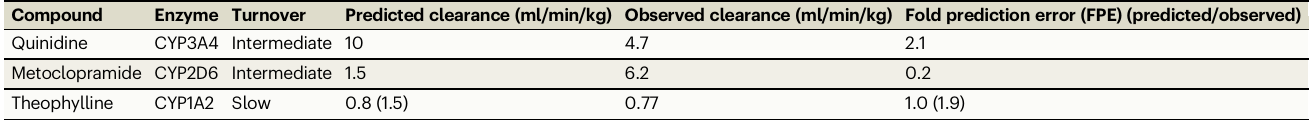
Table 1 | Summary of drug clearance experiments